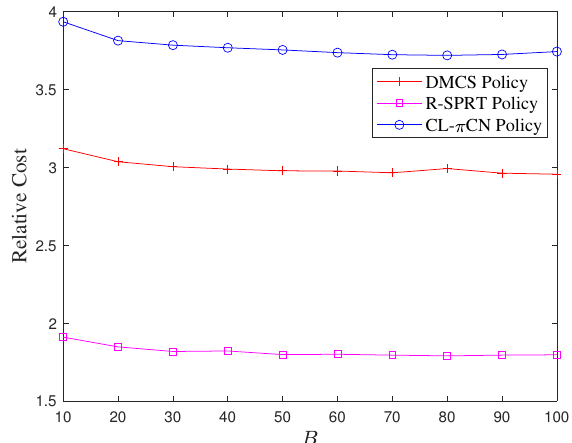
Figure 4. Performance comparison for M = 5, L = 2, s / B = 2, λ f = 1, λ g =